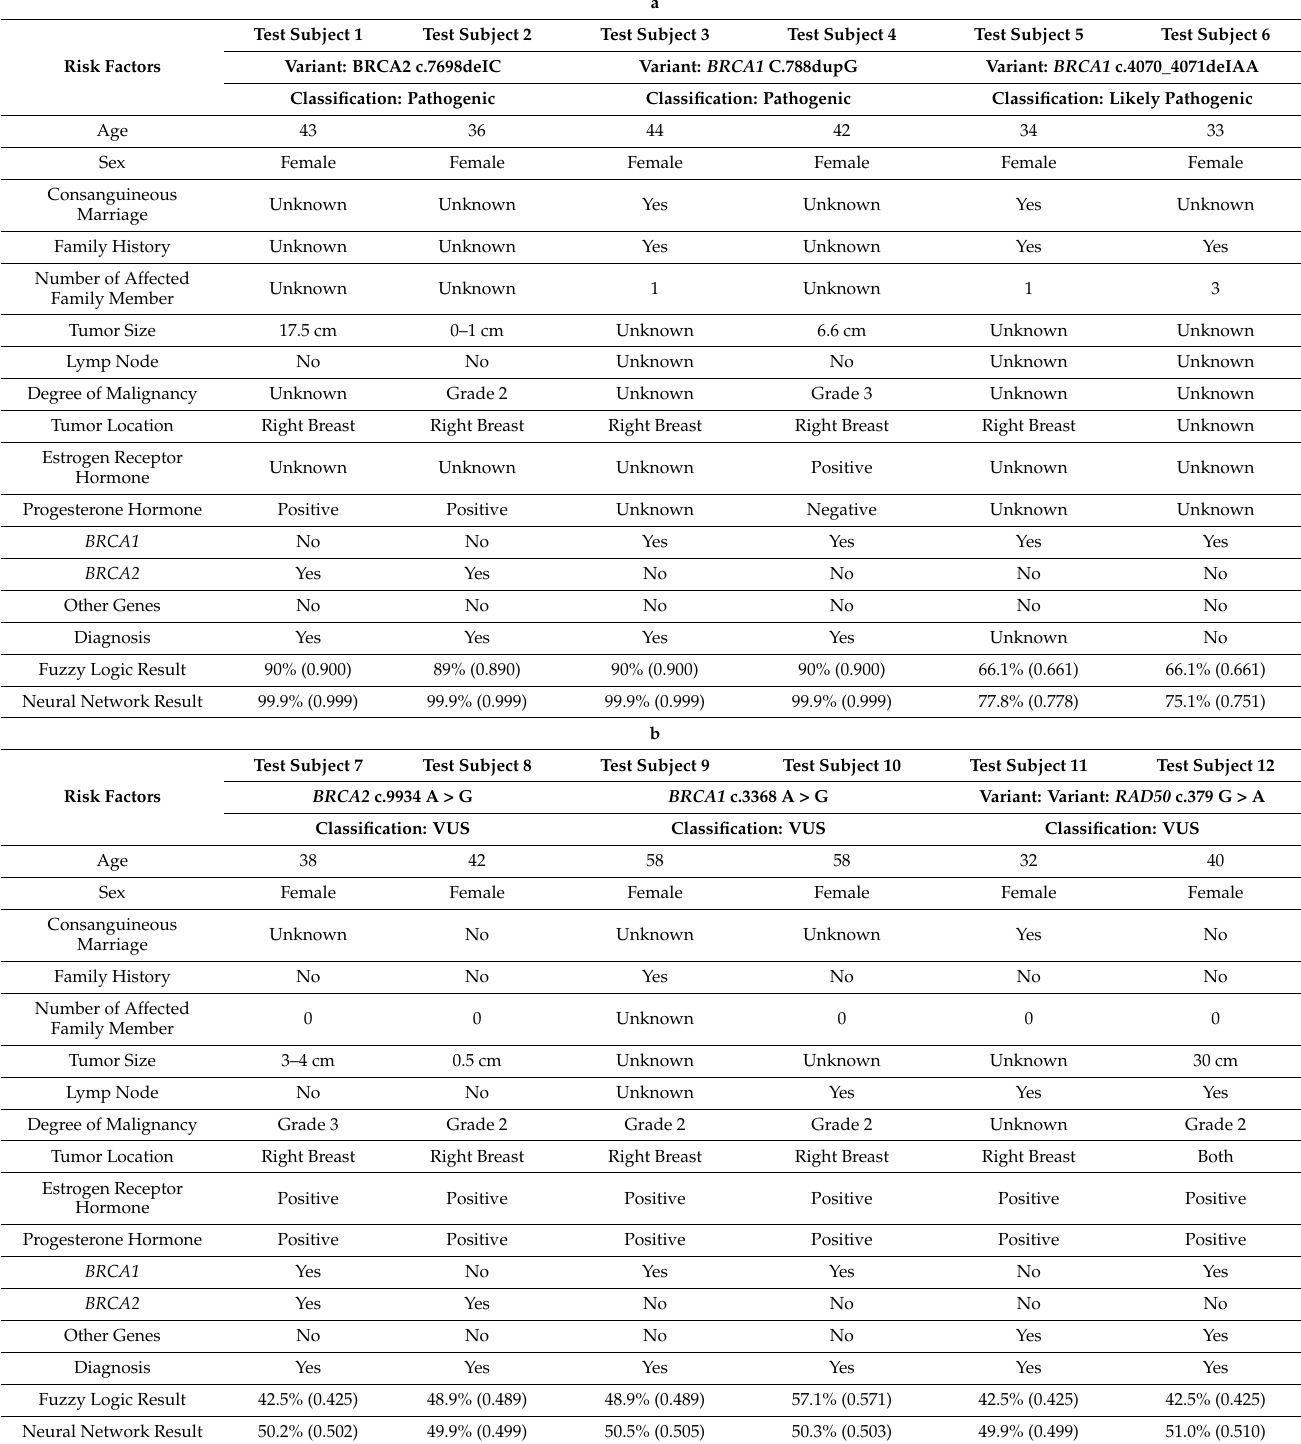
Table 4. a. Obtained results from testing the system. b. Obtained results from testing the system.